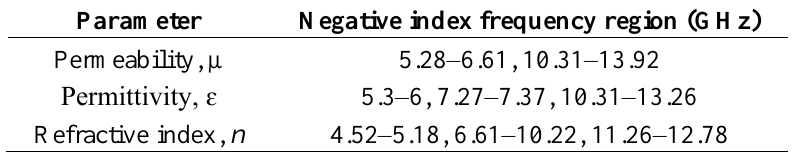
Figure 3. The observed effective parameters such as ( a ) permeability ( b ) permittivity ( c ) refractive index of the proposed unit cell. Table 2. Negative index frequency region of the retrieved effective